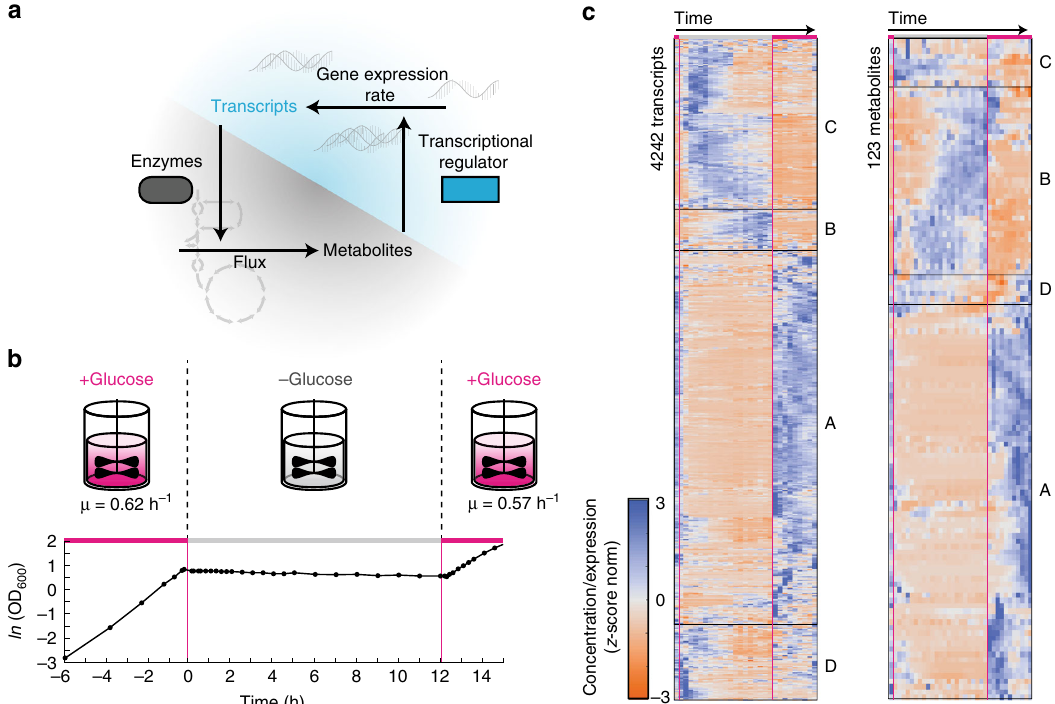
Fig. 1 Dynamic metabolomics and transcriptomics during the growth – starvation switch in E. coli . a Schematic of the mutual feedback between metabolism and transcription. Transcription regulates enzyme levels, which affect fl ux and metabolite concentrations. Metabolite concentrations regulate gene expression by allosteric interactions with transcriptional regulators. b Growth of E. coli during the switch between growth, carbon starvation, and back to growth. Cells were cultivated in a 1 L bioreactor on glucose minimal medium to an OD of 2 and then the medium was exchanged to minimal medium without carbon source. After 12 h carbon starvation glucose was added to the culture. μ is the growth rate calculated by linear regression in the fi rst and second growth phase. c Dynamic transcriptomics and metabolomics data measured at 29 and 35 time points, respectively. The fi rst measurement was before the switch to starvation, 19 samples were collected during starvation and 9 samples during exit from starvation. Shown are z-score normalized transcript levels (in TPM) of 4242 genes and the z-score normalized concentration of 123 metabolites. Blue indicates high expression/concentration; orange indicates low expression/concentration. Data are grouped by hierarchical clustering and the four largest clusters are indicated as clusters A – D (average cluster dynamics are shown in Supplementary Fig. 2). Source data are provided as a Source Data fi